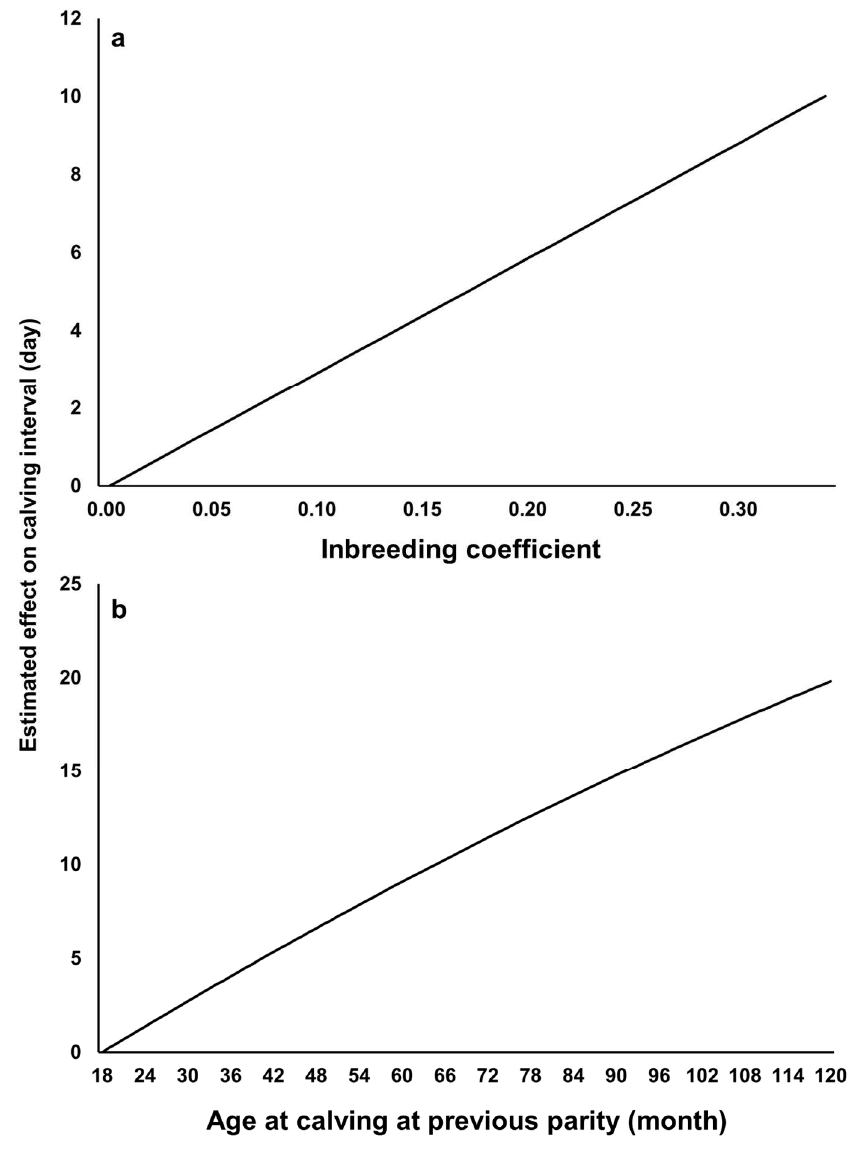
Figure 8. Estimated effects of ( a ) inbreeding coefficient of cow and ( b ) age at calving of cow at previous parity by repeatability model analysis.